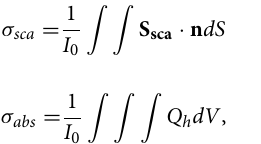
2 π (cid:31) √ ε m is the wavenumber of light in the surrounding medium. Note that the electric field distribution is = computed using Helmholtz equation 46 .